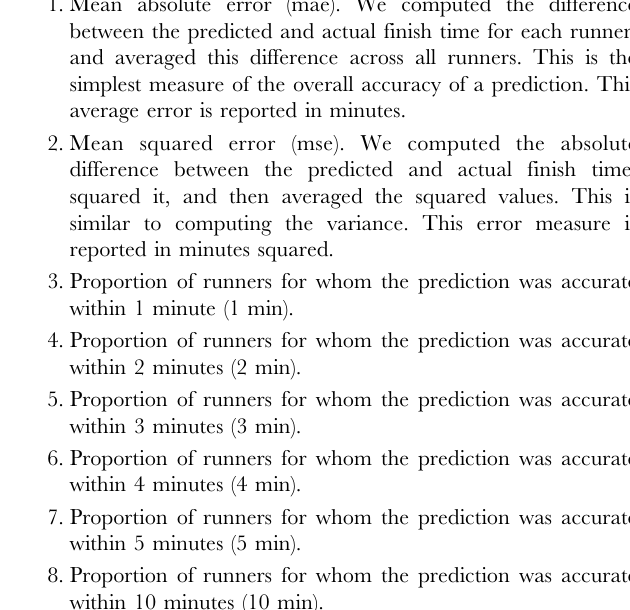
Figure 5. Restriction prediction error box plots. Boxplots of prediction errors in the validation dataset, restricted to runners for whom the prediction error was less than 10 minutes.